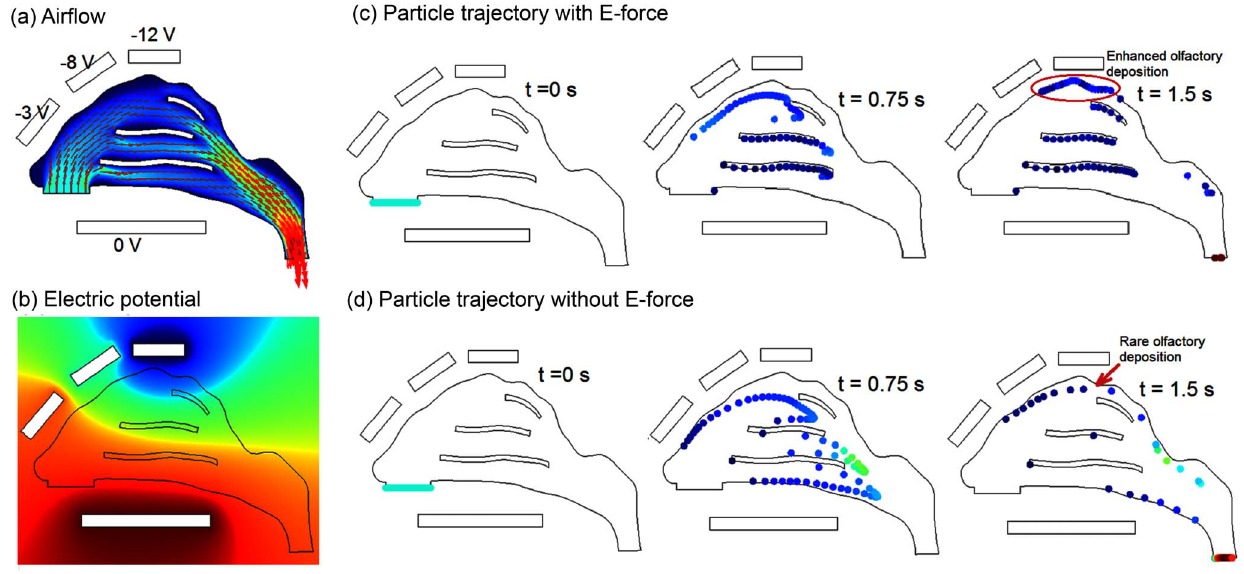
Figure 3. Dynamics of 2-D intranasal delivery: (a) airflow, (b) electric potential field, (c) particle trajectories with electrophoretic forces, and (d) particle trajectories without electrophoretic forces. In the electric field, the red color represents zero voltage and the blue color represents negative voltages.